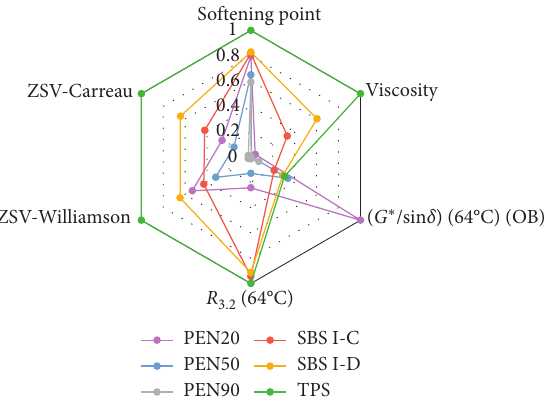
Figure 4: High-temperature performance distributions of six asphalt binders in hexagonal envelope